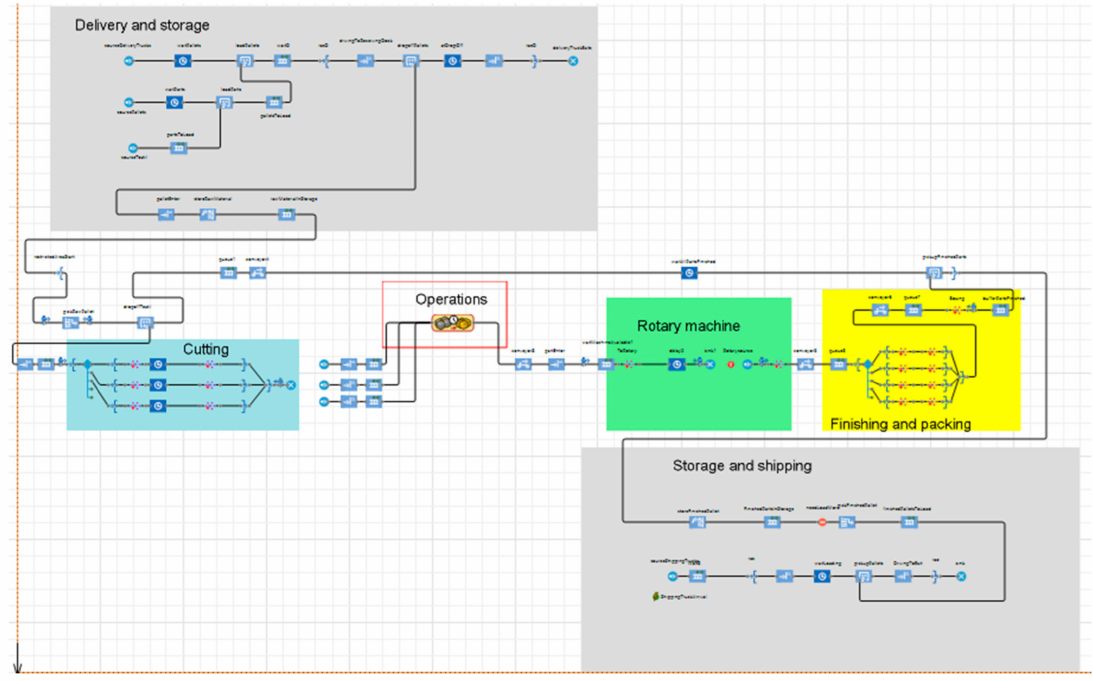
Figure 6. Block diagram of the direct-injection